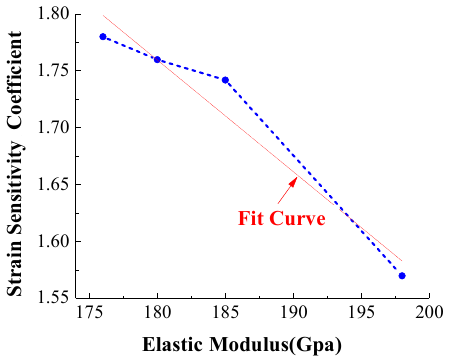
Figure 7. Test results of strain sensitivity coefficient.